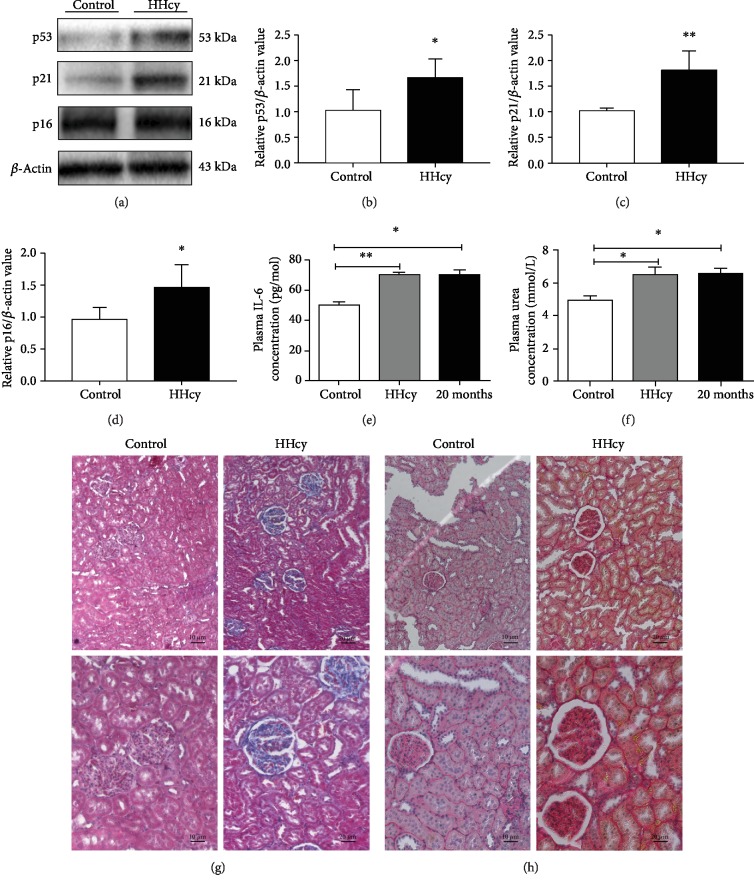
HHcy led to the development of renal aging. (a) Representative Western blot showing the increased expression of aging-related proteins in the kidneys of the HHcy rats (b–d). Quantification of the protein levels of p53, p21, and p16, respectively (∗P < 0.05, ∗∗P < 0.01vs. Control, n = 4-5). (e) Serum level of the aging-related inflammatory cytokine IL-6 (∗P < 0.05, ∗∗P < 0.01vs. Control, n = 6-10). (f) Serum level of urea increased in both HHcy and natural aged mice (∗P < 0.05vs. Control, n = 6-10). (g) Masson staining of fibrotic lesions in kidney tissue. (h) Sirius red staining of fibrotic lesions in kidney tissue. Control: control group; HHcy: hyperhomocysteinemia group; IL-6: interleukin-6. Data were expressed as mean ± SEM.